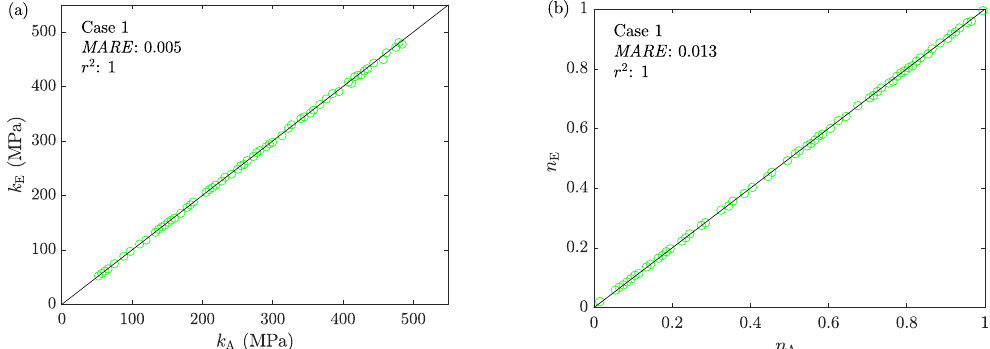
Figure 6. The correlation between the assigned ( m A ) and estimated ( m E ) values of the friction factor in Case 1. The continuous black line represents a perfect correlation.